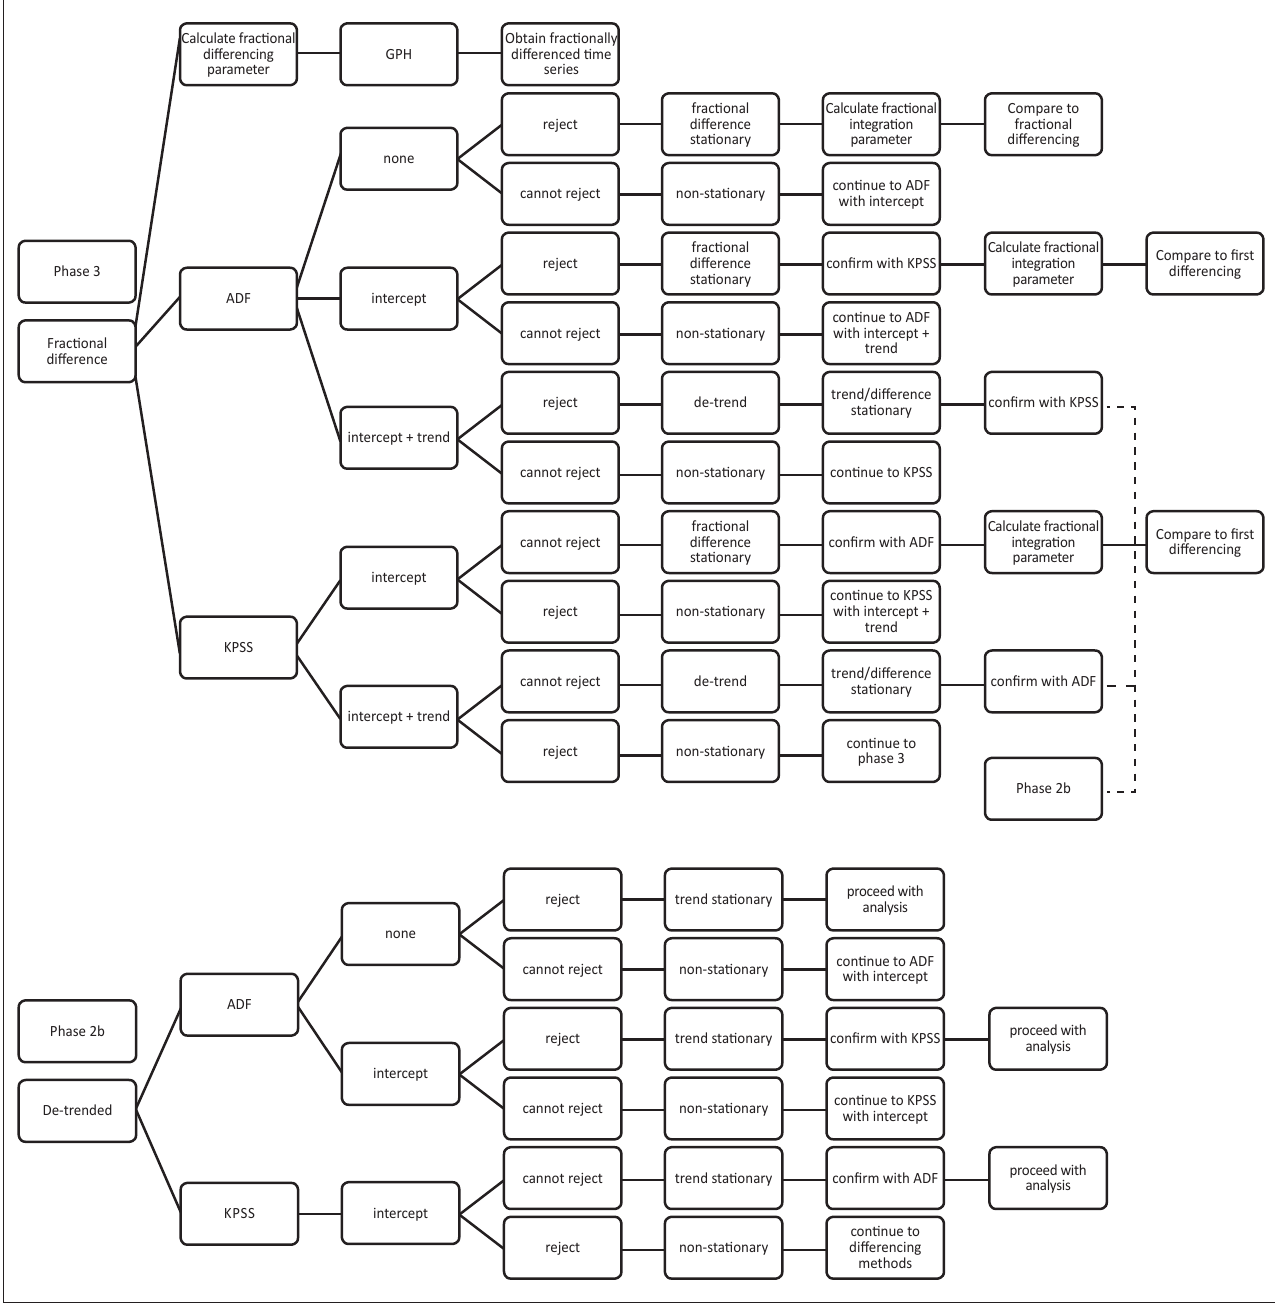
FIGURE 1A (Continues...): The process of rendering a non-stationary time series stationary (Phases 1, 2 and